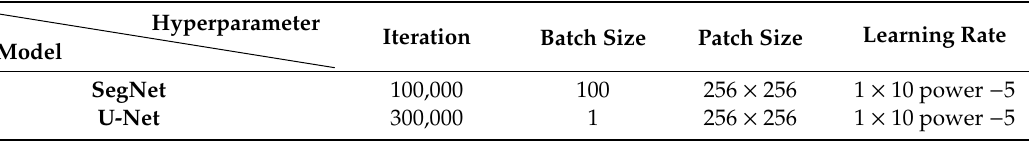
Table 3. Result of hyperparameter